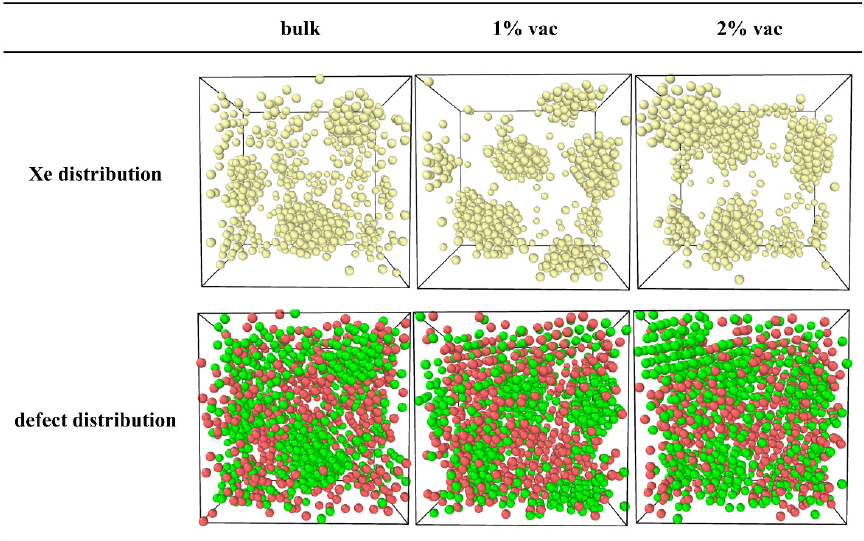
Figure 7. Xe clusters distribution and defects distribution at 5% concentration of Xe atoms in dif- ferent systems. The green, red, and yellow balls represent the lattice U vacancies, U interstitials, and Xe atoms.